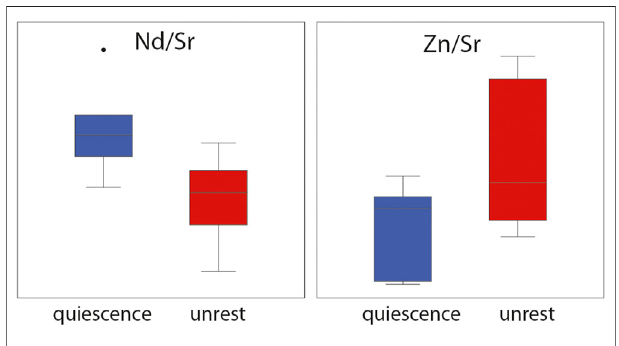
FIGURE 10 | Boxplots showing a characteristic and statistically signi fi cant (at α (cid:1) 5%) difference in Nd/Sr and Zn/Sr between active and quiet periods. The data were smoothed and binned in 5-years intervals to account for the uncertainty in absolute age assignment.